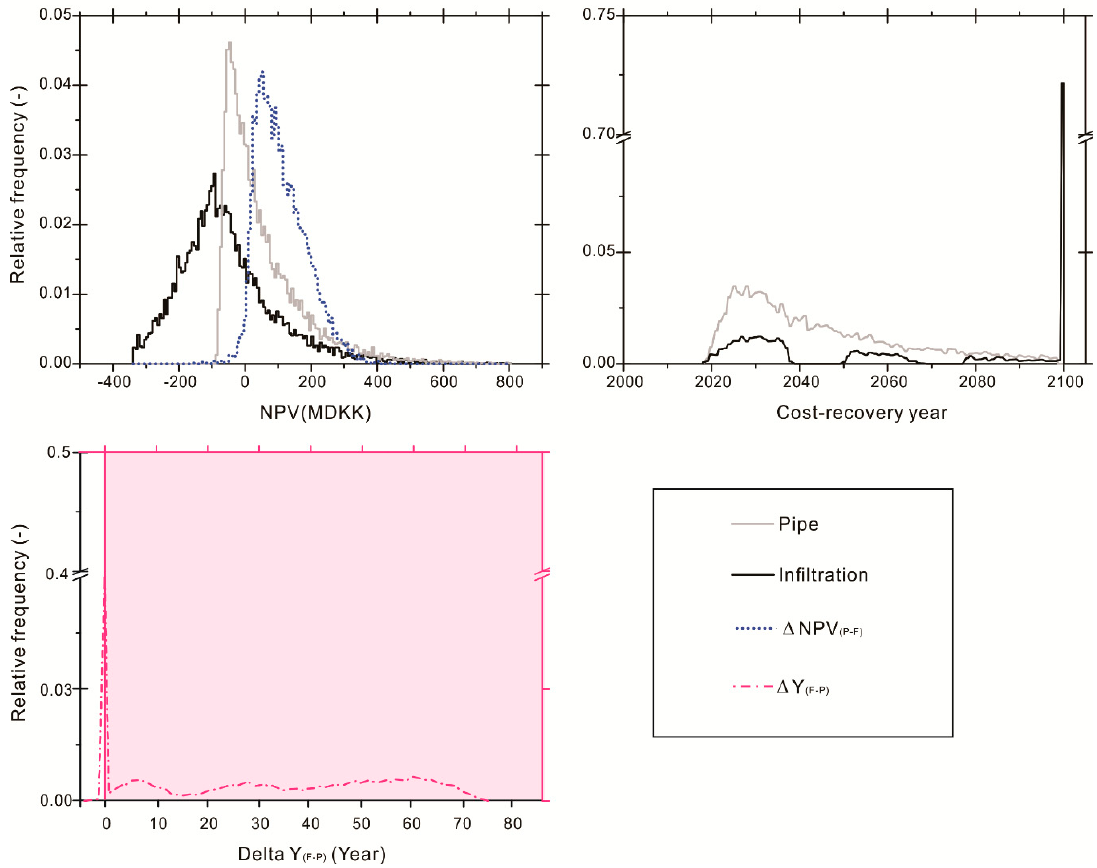
P F Δ Y , and the cost-recovery year of the two −